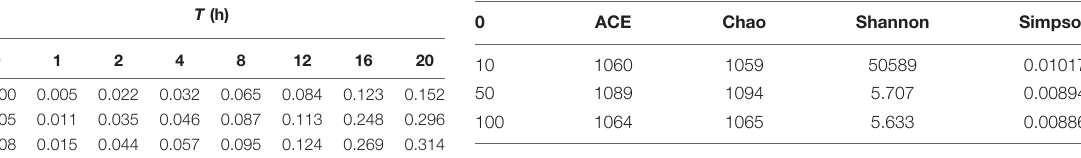
TABLE 4 | Head loss along DN-DBF (m H 2 O). TABLE 5 | Bacterial richness and diversity along DN-DBF.